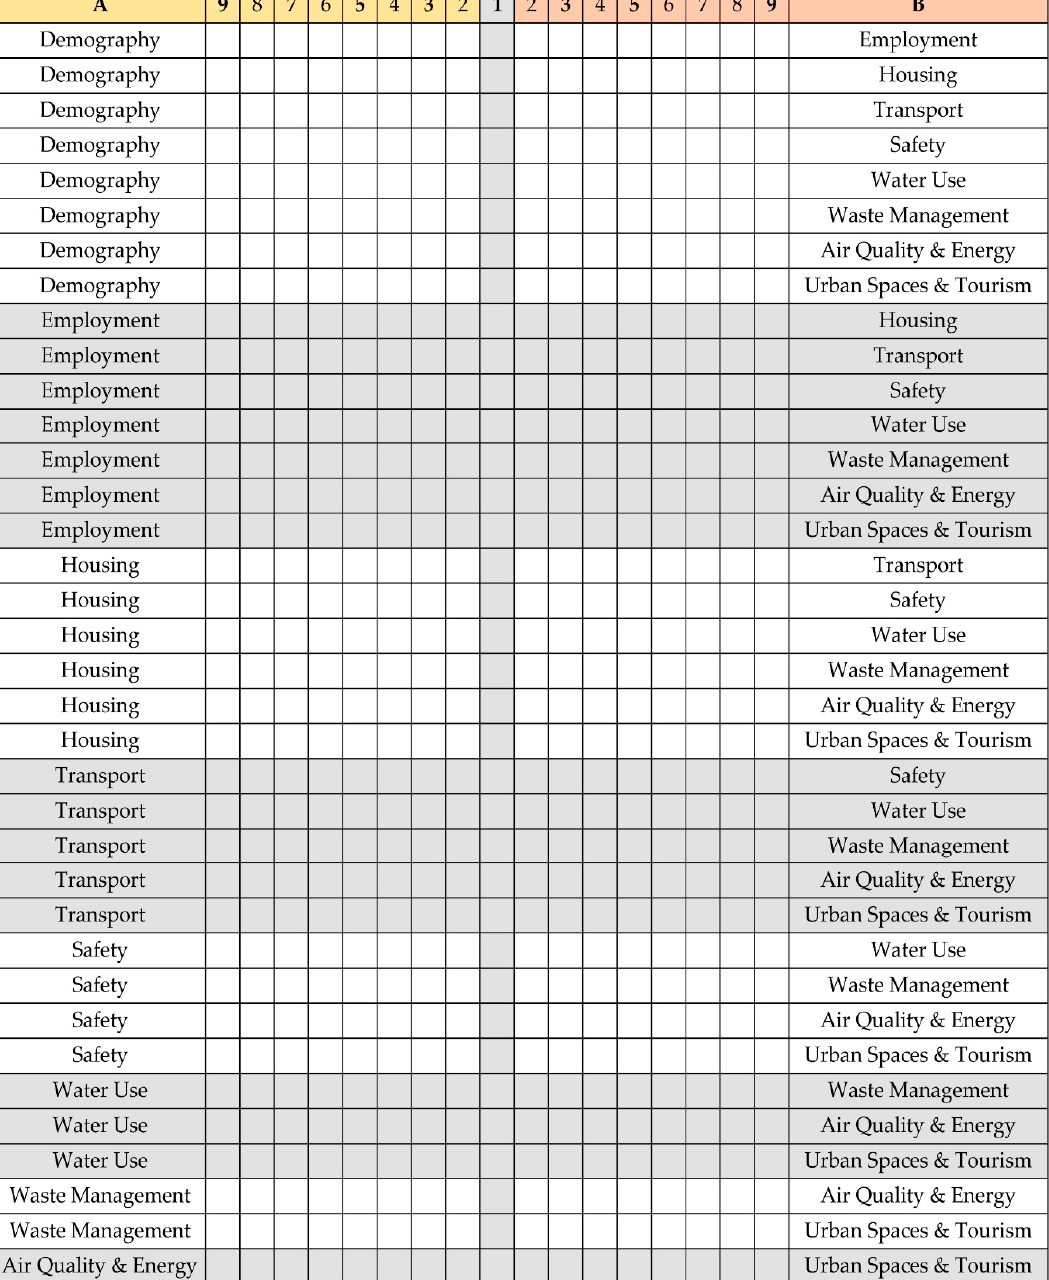
Figure A1. AHP questionnaire for prioritizing the criteria. Note: 1 = Equal importance, 3 = Moderate importance, 5 = Strong importance, 7 = Very strong importance, 9 = Extreme importance (2,4,6,8 ‐ Values in ‐ between).